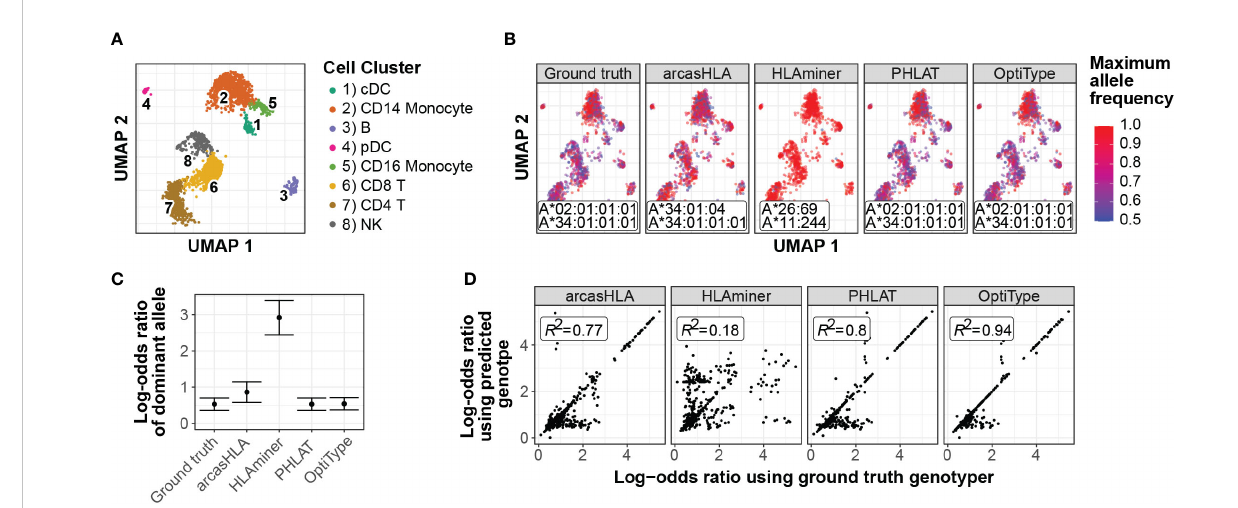
FIGURE 7 Effect of prediction accuracy on analysis of allele-speci fi c HLA-A expression (A-C) Representative sample from 5 ’ data set. (A) UMAP projection of single-cell transcriptome data, annotated as previously described (4) (B) UMAP plots colored by cell-speci fi c expression frequency of the most highly expressed HLA allele determined by scHLAcount. The reference genotype from each genotyper used by scHLAcount is annotated. (C) Summary log- odds ratios of dominant HLA-A allele from all cells in cDC cluster determined by random effects model. Error bars represent summary standard error. (D) Correlation of ground truth- and genotyper-derived HLA-A allele log-odds ratio from all samples and cell